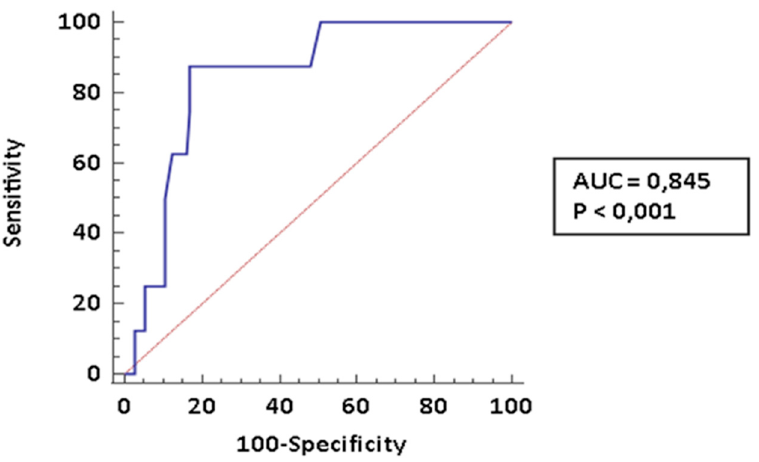
Figure 1. ROC curve for peak VO 2. We diagnosed 8 CTD-PAH.